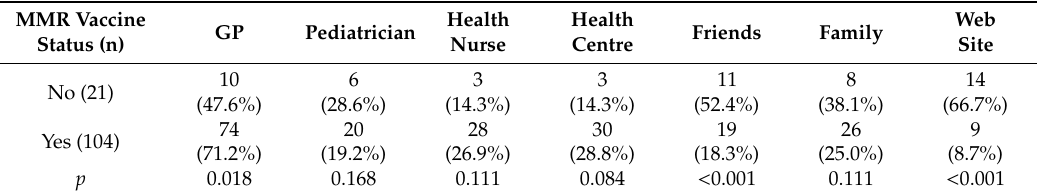
Table 2. Frequency within MMR Vaccine status group of information sources accessed by parents and expectant parents.